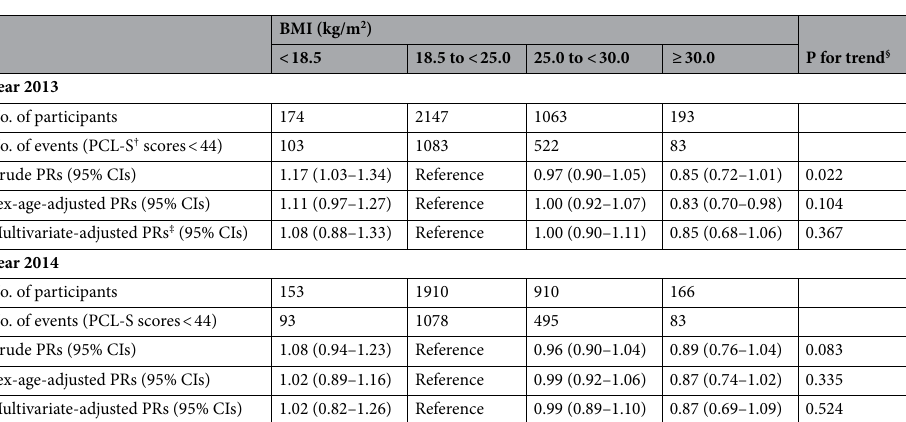
Table 2. PRs † and 95% CIs † of recovery from probable PTSD † according to BMI † in 2012. † PR, prevalence ratio; CI, confidence interval; PTSD, post-traumatic stress disorder; BMI, body mass index; PCL-S, Post- traumatic Stress Disorder Checklist-specific. ‡ Multivariate-adjusted PRs were adjusted for sex, age (< 30 years,